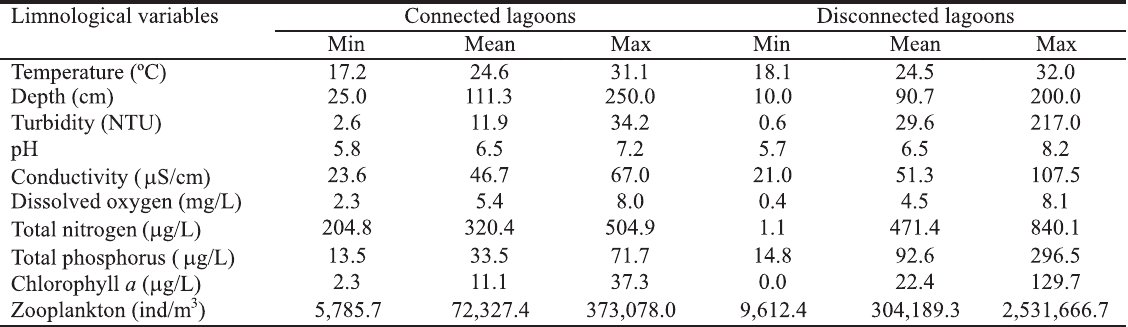
Table 2. Limnological characteristics of connected and disconnected lagoons.